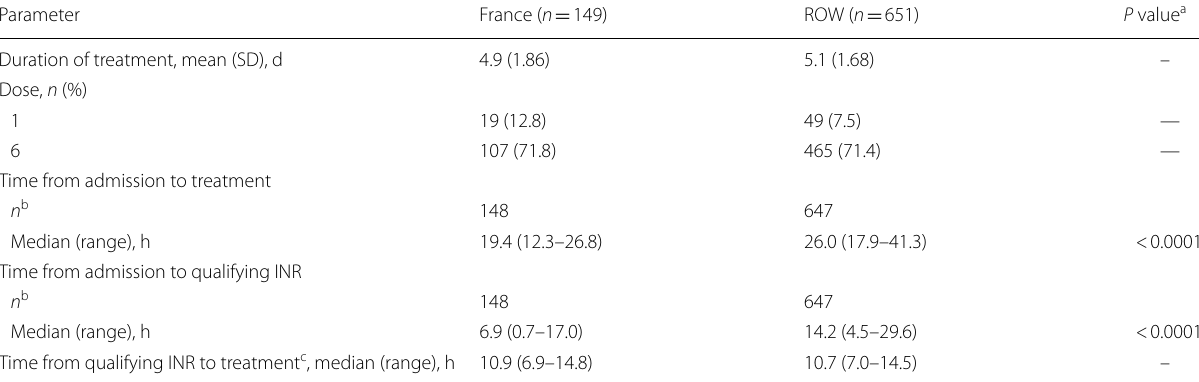
INR international normalized ratio, ROW rest of world (excluding France), SD standard deviation a For comparison of patients in France vs those from the ROW by Wilcoxon 2-sample test b Total n for the parameter; data missing for some study patients c The study protocol limited the maximum time from qualifying INR to treatment